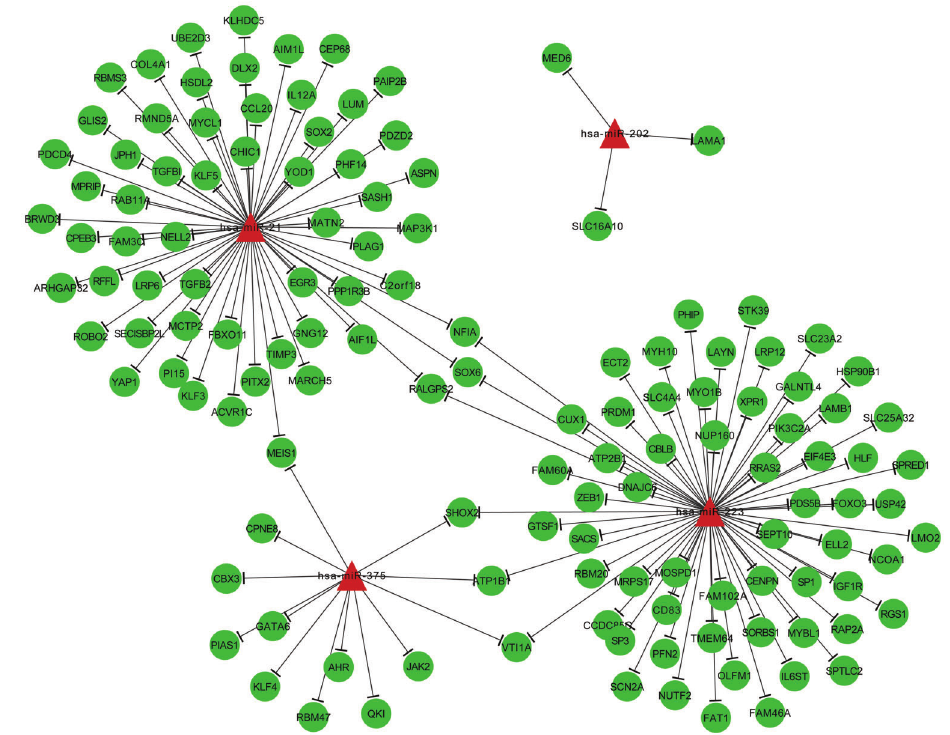
Figure 3. Regulatory network of selected miRNAs and their differentially expressed target genes in esophageal squamous-cell